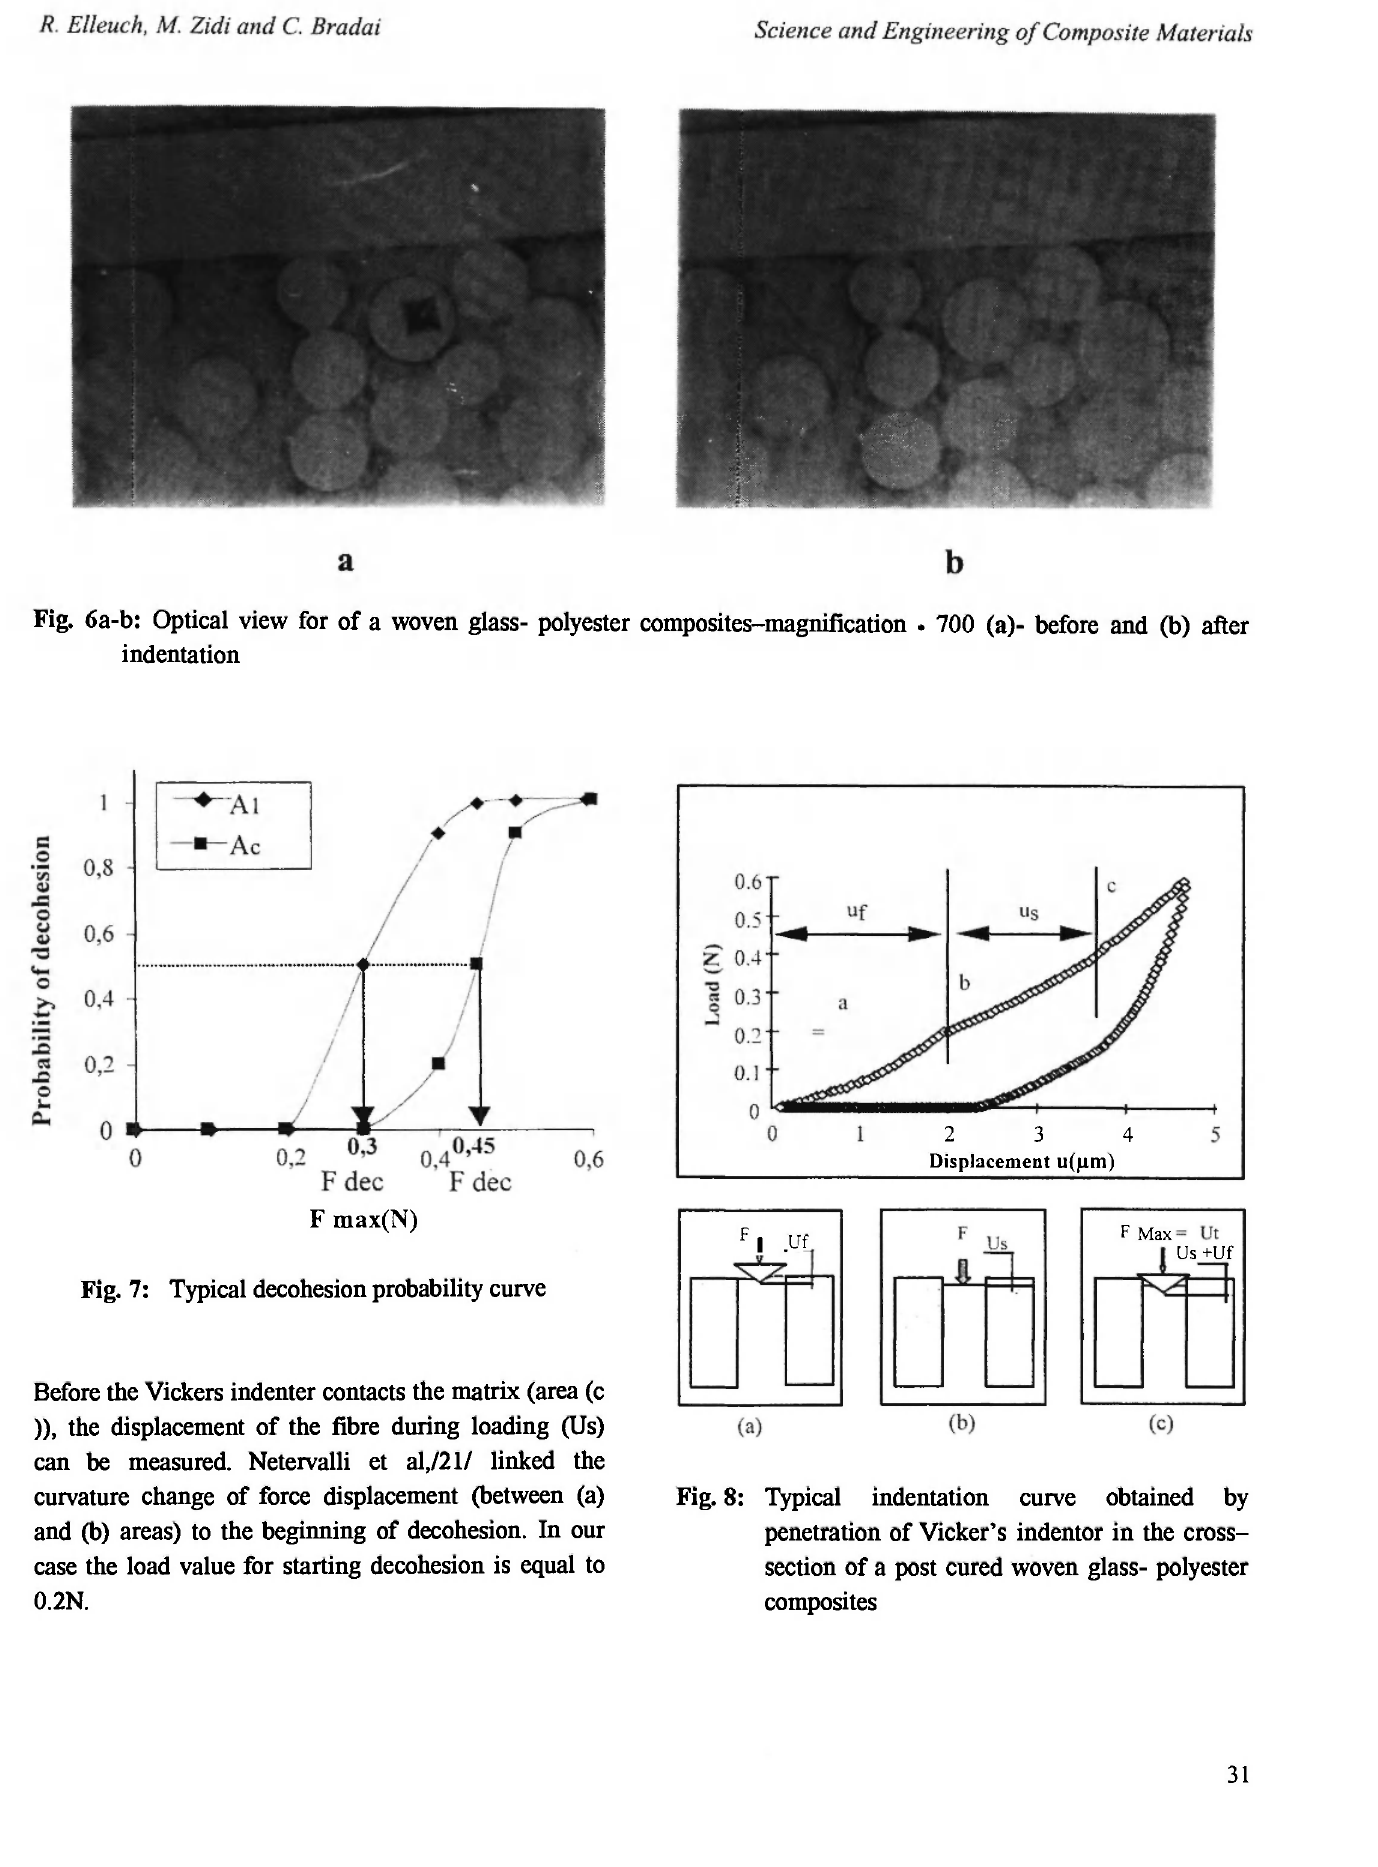
Fig. 8: Typical indentation curve obtained by penetration of Vicker's indentor in the cross- section of a post cured woven glass- polyester